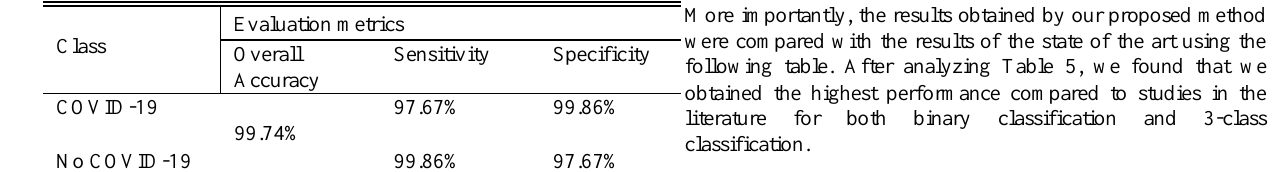
classification (COVID-19 vs. Normal vs. Pneumonia),